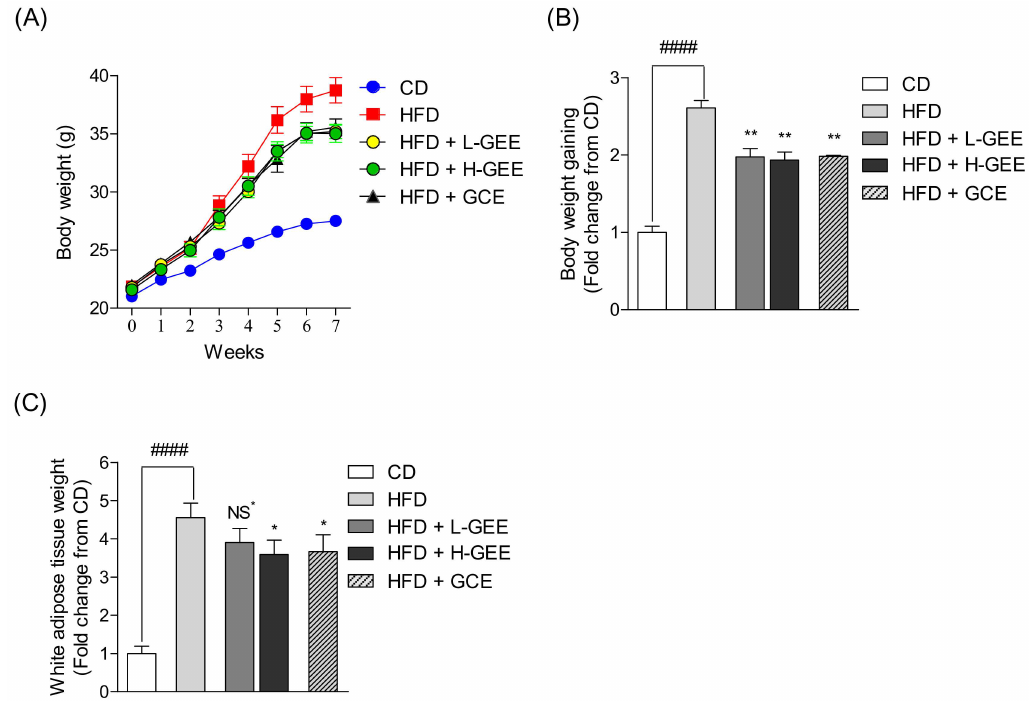
Figure 3. E ff ect of GEE on body weights and fat weight gain in high-fat diet (HFD)-induced mice: ( A ) Comparison of body weight, ( B ) body weight gain during 7 weeks, and ( C ) white adipose tissue weight at 7 weeks. Data are expressed as the mean ± SD, ( n = 3) in each group. Significant di ff erences were identified at * p < 0.05, ** p < 0.01, as compared to the HDF group, and # p < 0.05, #### p < 0.0001, as compared to the control group. NS; Not